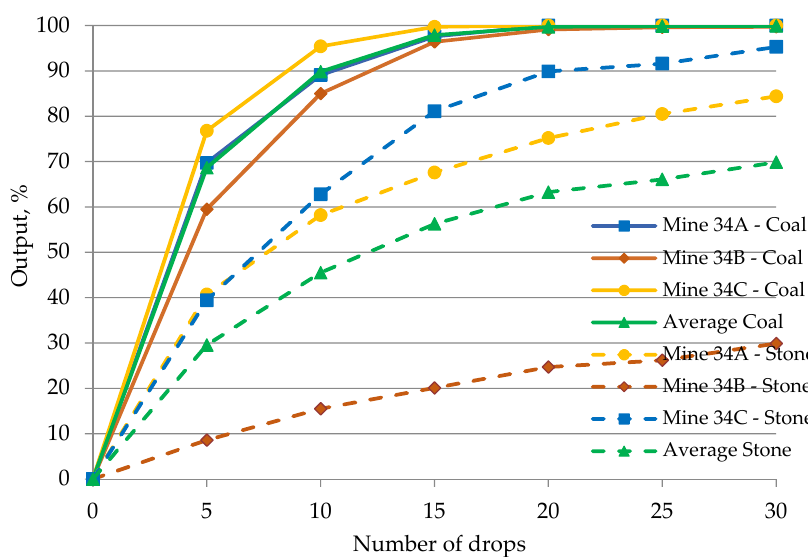
Figure 4. Comparative results of the 80-0 mm class output depending on the number of drops—coal grains (type 34) [43].